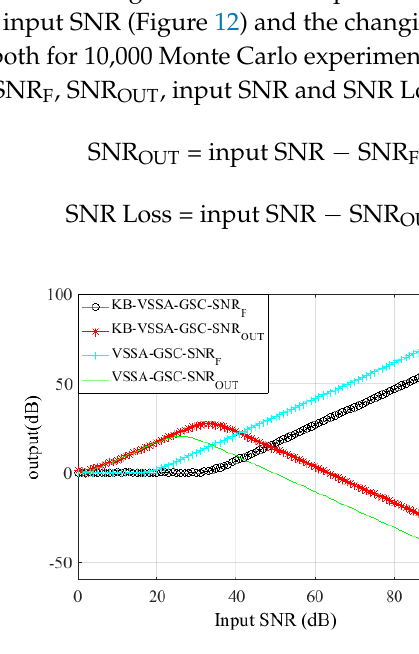
Figure 12. Single notch filter output SNR (SNR F ) and GSC output SNR (SNR OUT ).